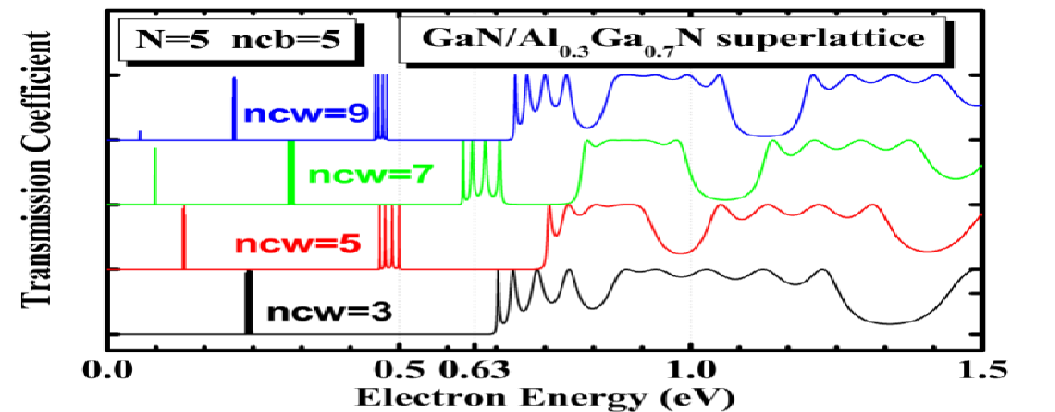
Fig. 5: Transmission coefficient T(E) versus incident energy (E) for GaN/Al system by varying well width with ncw = 3, 5, 7, 9 ; having five barriers N=5 with constant barriers